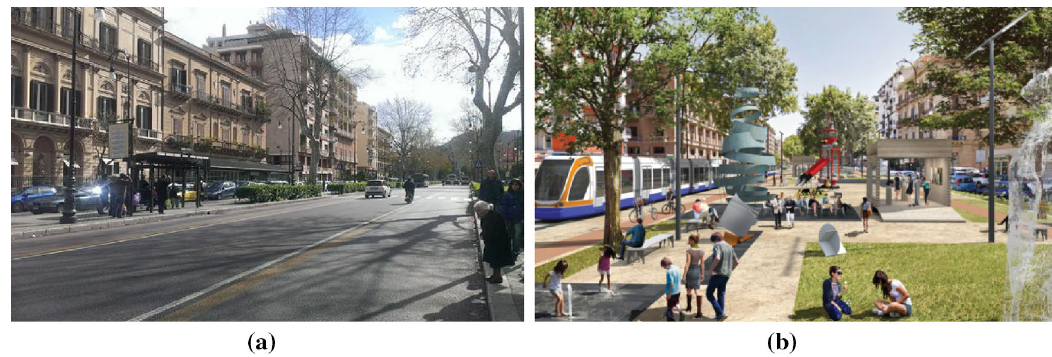
Fig. 5 Line A (‘‘Via Liberta`’’ segment). Current road section ( a ) and new proposed road section ( b